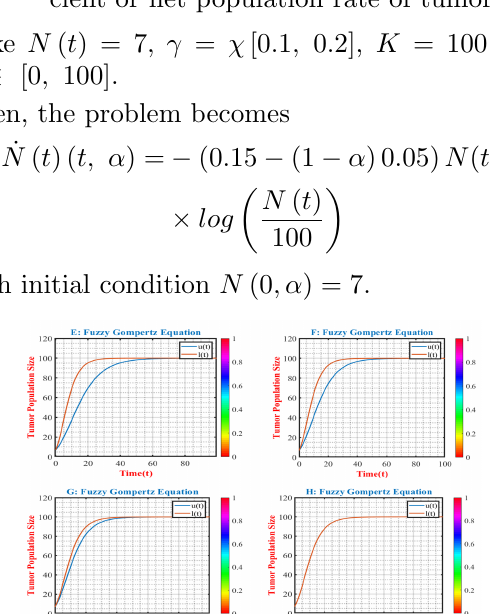
Figure 5. In this case, the system of Gompertz equation with both initial condition and the coefficient as fuzzy is defined and the tumor population size as a function of time for α = 0, α = 0 . 25, α = 0 . 75 and α = 1 are il- lustrated.